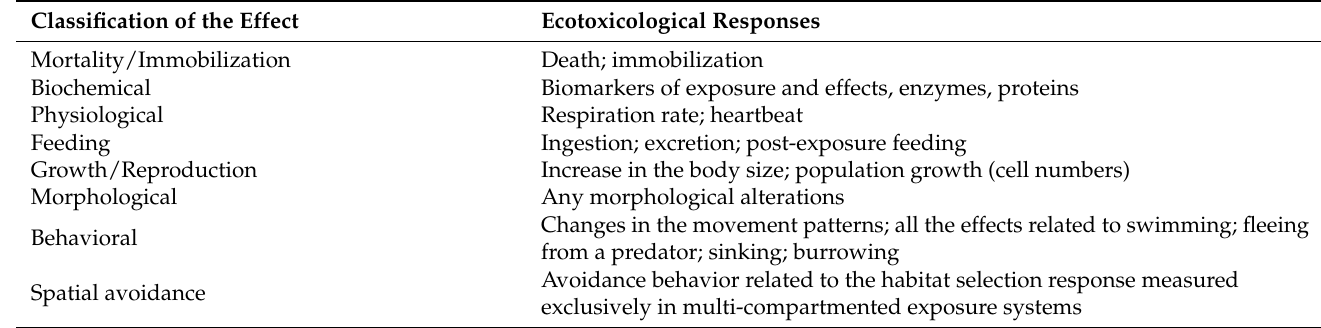
Table 1. Classification of the ecotoxicological responses used in the sensitivity profile of the three chemicals used in the current study by biological